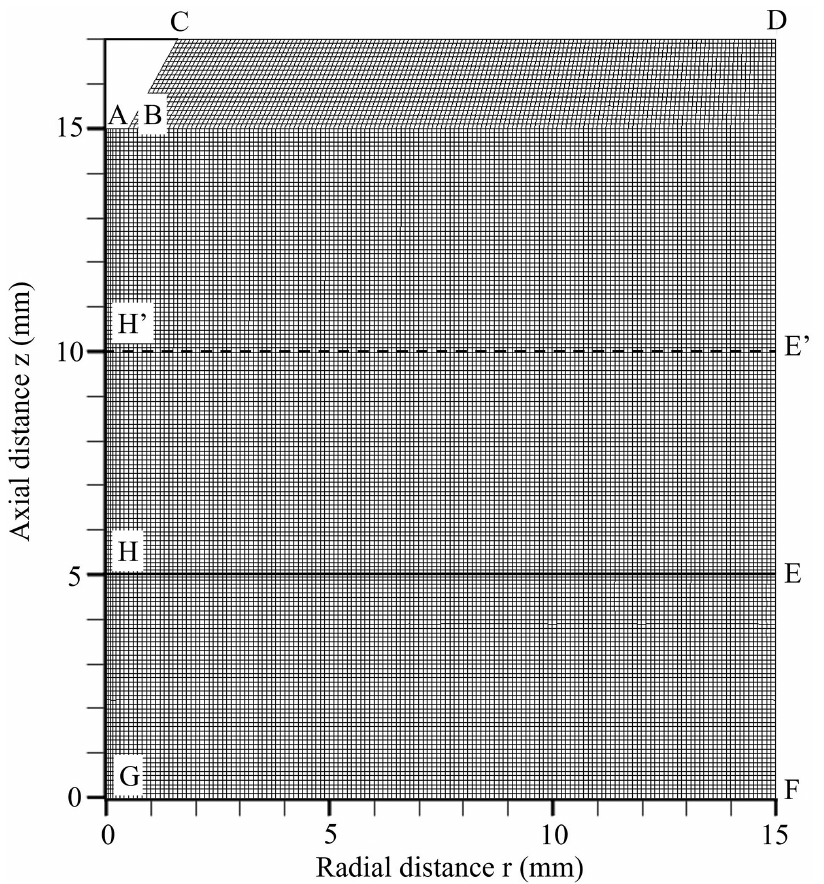
Figure 3: Calculation domain and mesh.